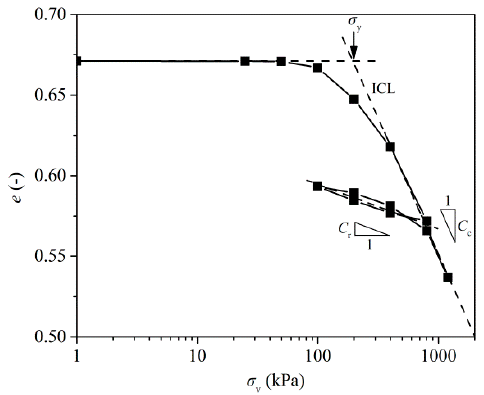
Figure 9. e − log σ v relationship of saturated untreated GRS.